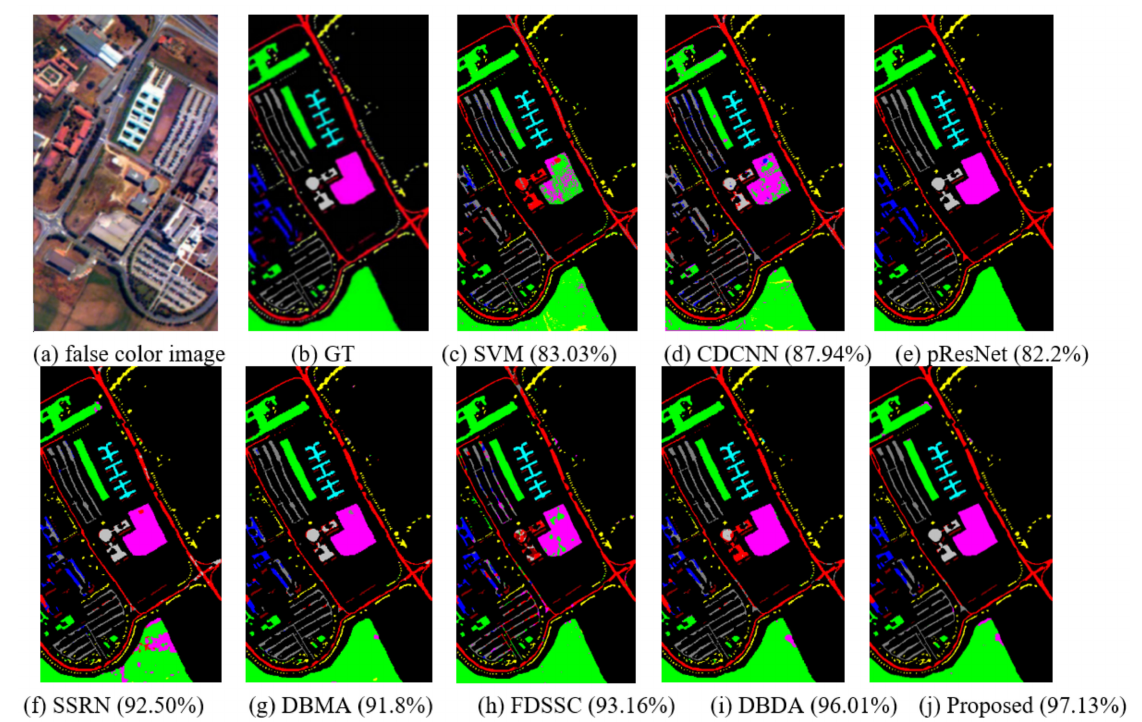
Figure 8. Classification maps of UP data set using 0.3% training samples: ( a ) false color image,